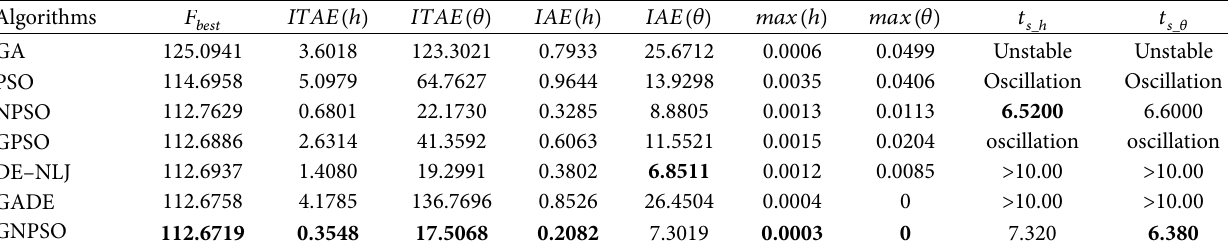
Table 16: Comparison of the best control performance obtained by GA, PSO, NPSO, GPSO, DE–NLJ, GADE and GNPSO for MIMO non- linear wing vibration system.